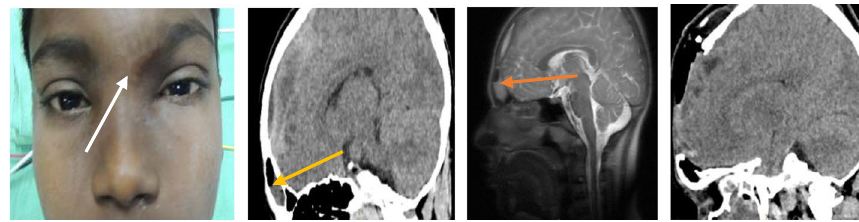
Fig. 2 a – d Representative images of case series 1. a Clinical picture of the patient with a 2 sinus collection extending up to ® frontal lobe with (R) frontal lobe abscess on CT scan. d Extradural collection in frontal region in midline with (R) frontal lobe abscess on MRI. e Post-surgery CT scan after wide bifrontal decompressive